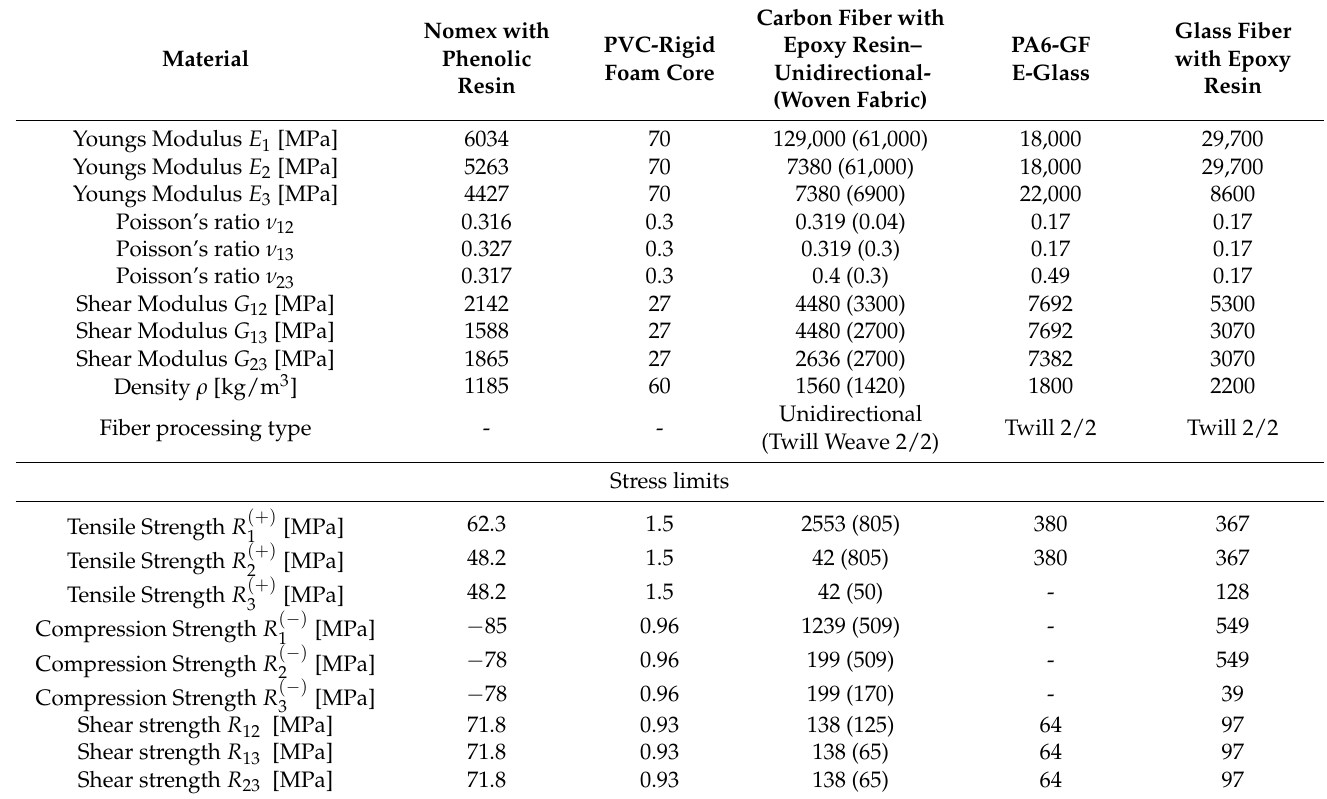
Table 4. Material properties of the acoustic liner